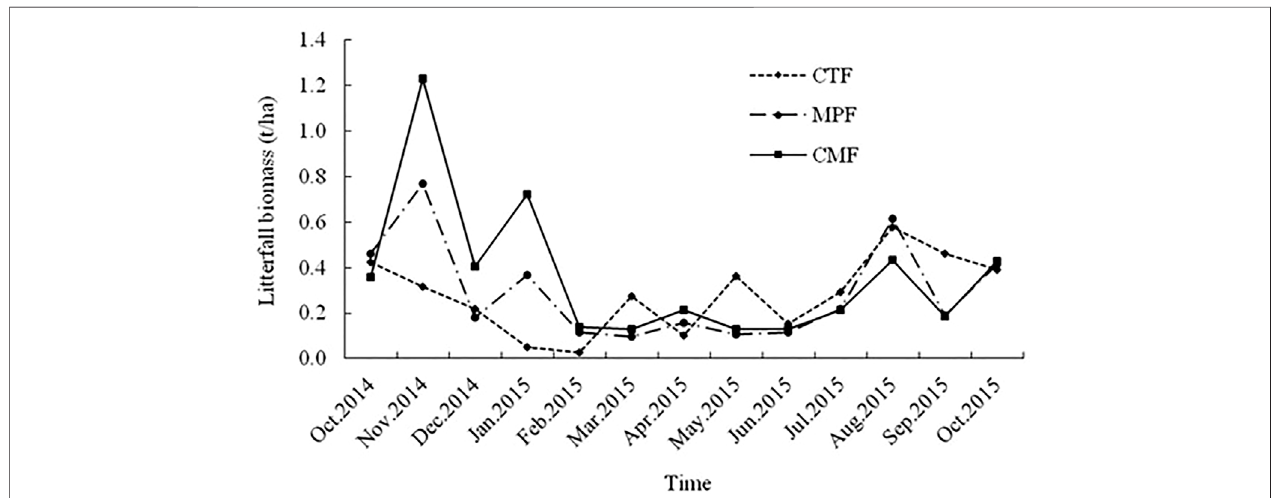
FIGURE2| Seasonalchangesintotallitterfallbiomassinthethreeexaminedforesttypes.CTF,camphortreeforest;MPF,Massonpineforest;CMF,camphortree and Masson pine mixed forest.